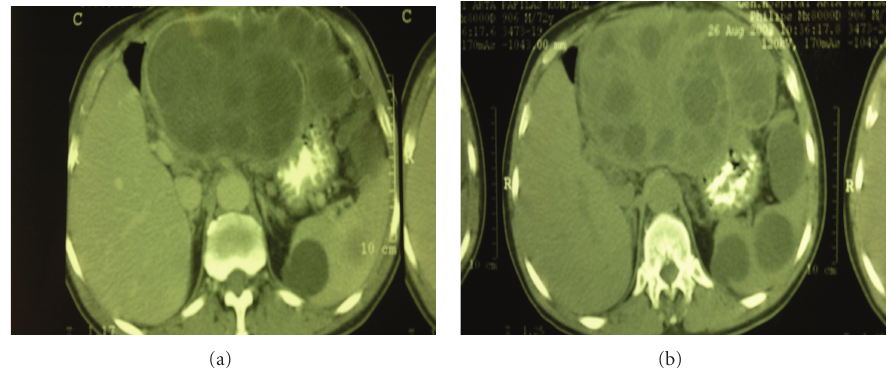
Figure 1: CT showed a large echinococcal cyst with daughter cysts in the left lobe of the liver, splenic echinococcosis and a large echinococcal cyst in the left hypochondrium causing a huge pressure to the